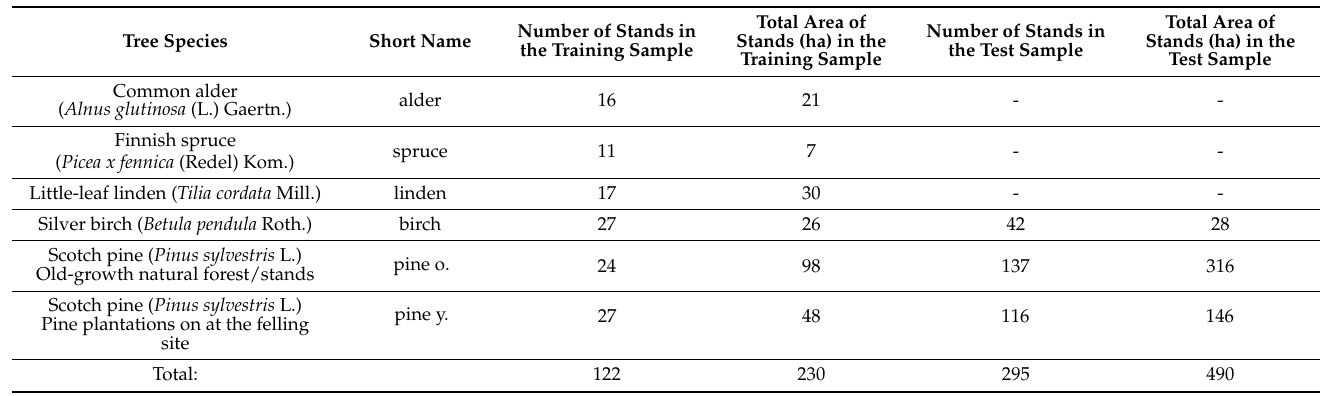
Table 3. Trees species in the training and control